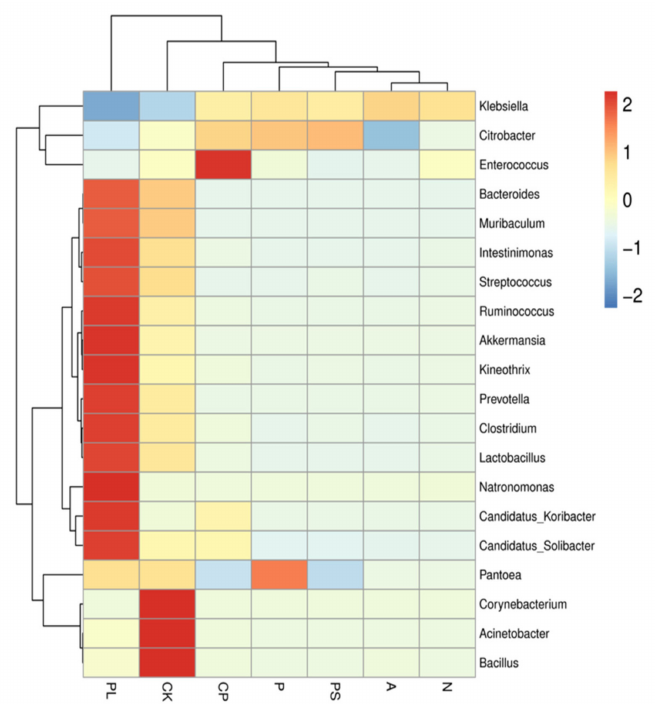
Figure 4. Cluster heat map of the 20 most abundant genera in the bacterial community. The columns represent the samples and the rows represent the bacterial OTUs assigned to the genus level. Dendrograms of hierarchical cluster analysis grouping genera and samples are shown on the left and at the top,